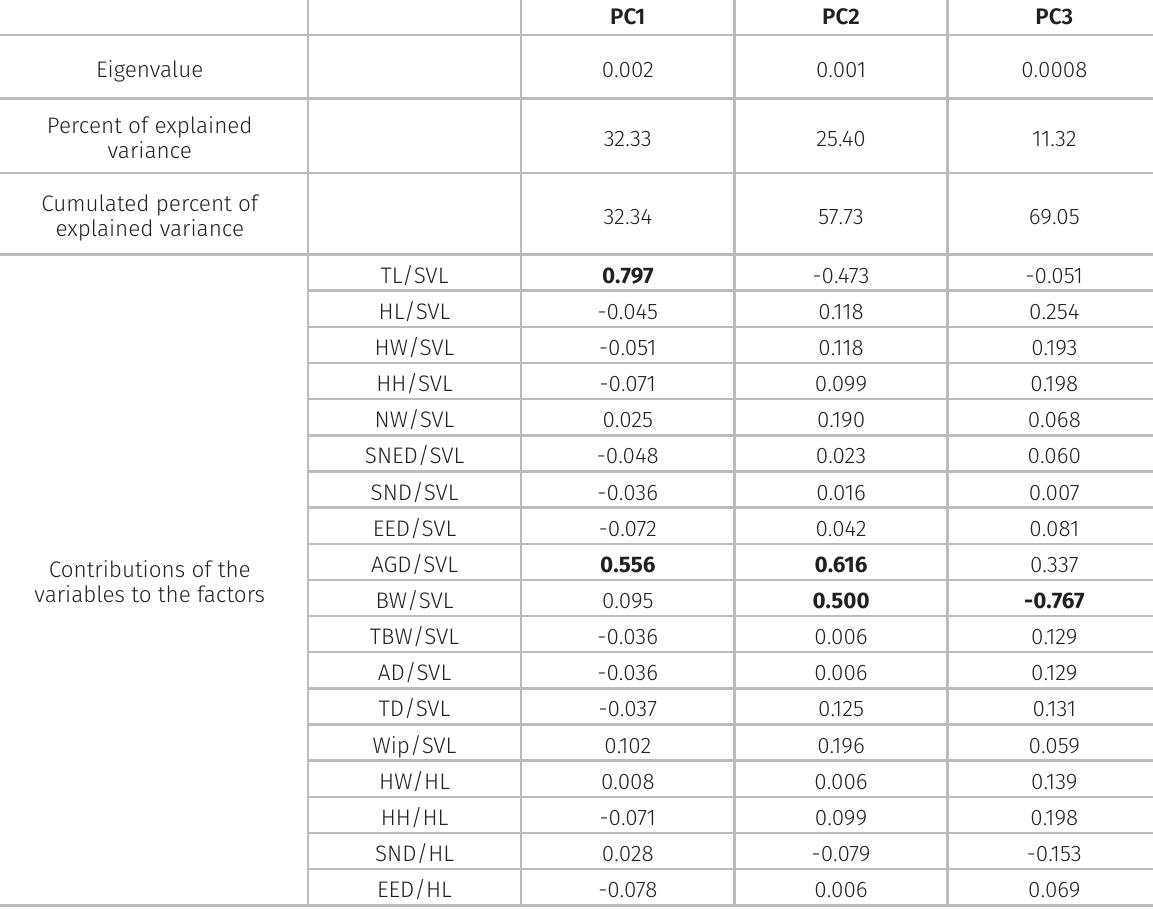
Table III. Eigenvalues, percent of explained variance, accumulative percent of explained variance and the contributions of the variables to the factors for the first three principal components of a PCA performed on body ratios between females and males of Phymaturus